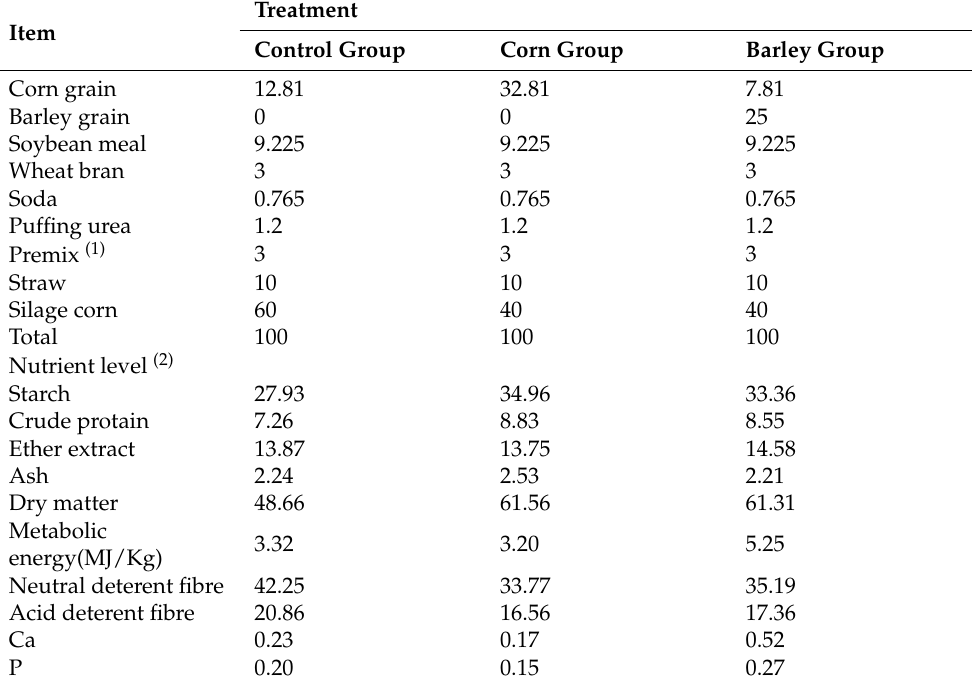
Table 1. Phase I dietary formulations and components